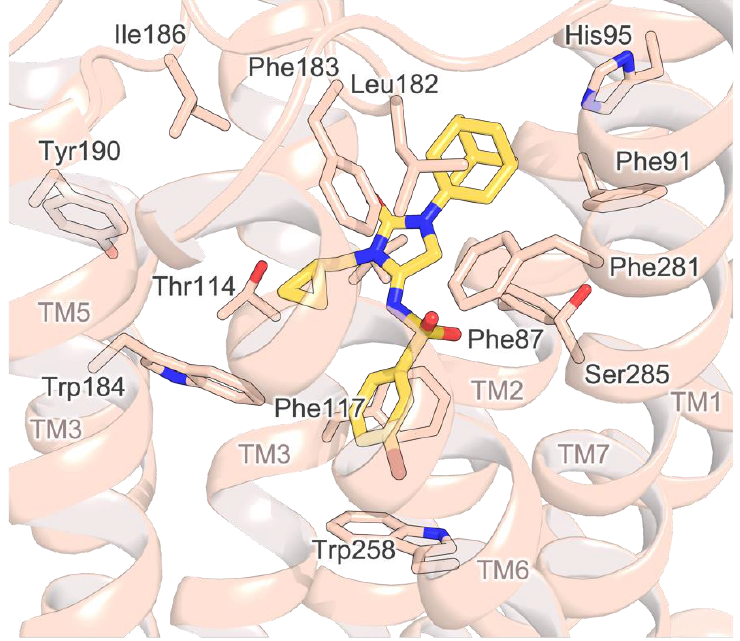
Figure 6. Docking poses of compound 12e in the antagonist conformation of the hCB2 receptor (PDB ID 5ZTY). Residues lining the binding site are represented as capped sticks and labeled; transmem- brane helices are numbered as TM1-7. Hydrogen bonds are represented as black dashed lines.